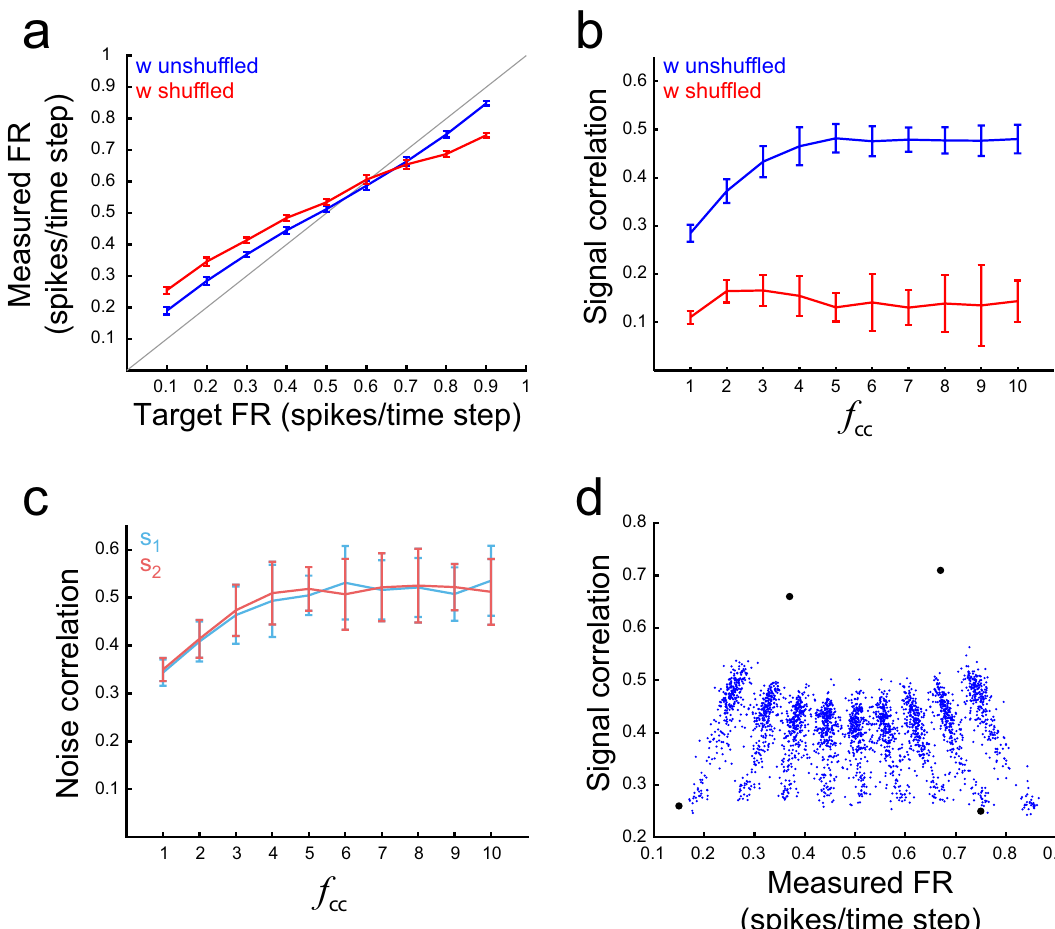
Figure 3. Imposing activity constraints with FTP. ( a ) FR measured in networks constructed to solve the s-task, as a function of the target FR. The FR of networks constructed with the FTP algorithm is close to the target FR (blue line). There is a tendency to obtain lower firing rates for target FR values above 0.5 spikes/time step, and higher firing rates for target FR values below 0.5 spikes/time step (the gray line is the identity function). The same networks with their synaptic weights shuffled (red line) show a similar relationship between target FR and measured FR, albeit with a lower slope. A total of 30 networks were generated for each target FR. Weights in W in and W rec were shuffled separately. Mean ± SD are shown. ( b ) Correlation between pairs of integration neurons as a function of the scaling factor f cc . Pairwise correlation, computed over all time steps, increases with f cc until it saturates at CC = 0.48 for f cc ≥ 5 (blue line). Networks with their afferent synaptic weights shuffled (red line) show low correlation, invariant to f cc . A total of 30 networks were constructed for each f cc value, with target FR set to 0.1 spikes/time step. Mean ± SD are shown. ( c ) Pairwise correlation computed separately for s 1 and s 2 (noise correlation). The correlation coefficient increases with f cc , similarly for both stimuli and closely following correlation values in (b). Mean ± SD are shown, n = 30. ( d ) Measured FR as a function of pairwise correlation. Each blue dot shows the FR and CC of one network constructed to solve the s-task with desired FR and CC imposed through U base initialization. Values for 2700 networks are shown. Points form stripes pointing towards FR = 0.5 spikes/time step, each stripe corresponding to networks with the same target FR. As correlation increases, the measured FR tends to 0.5 spikes/time step. Black dots show FR and CC of 4 networks for which desired FR and CC were imposed by evolution of a population of U base